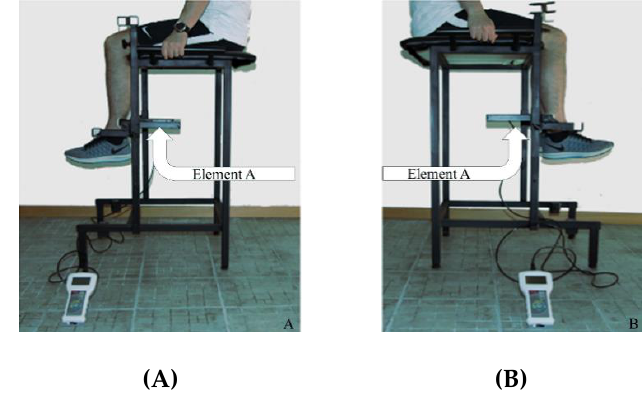
Figure 1. Isometric-Bench: flexion setting for left ( A ) and right ( B ) lower limbs.